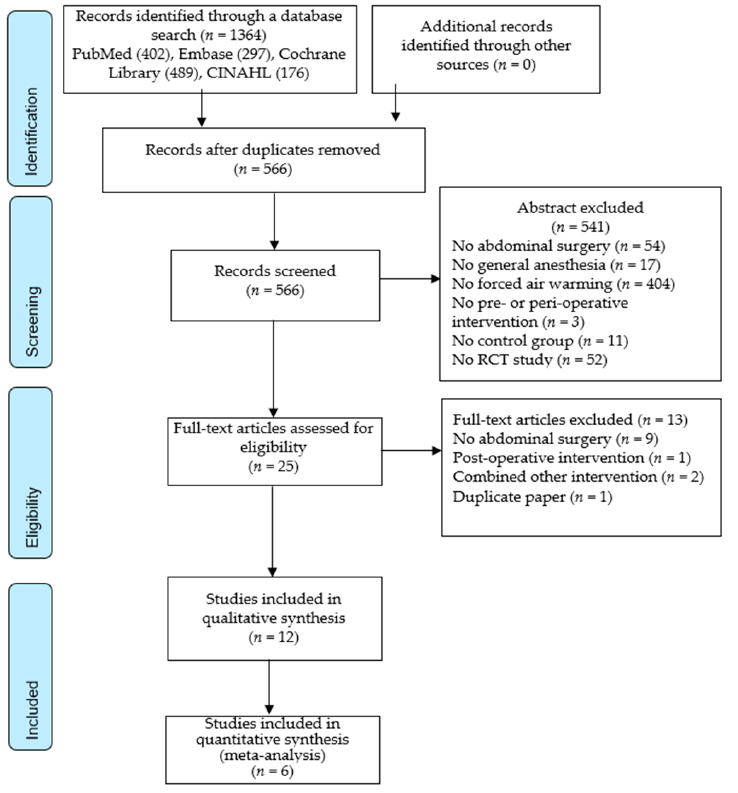
Figure 1. Preferred reporting items for systematic reviews and meta-analyses (PRISMA) flow.